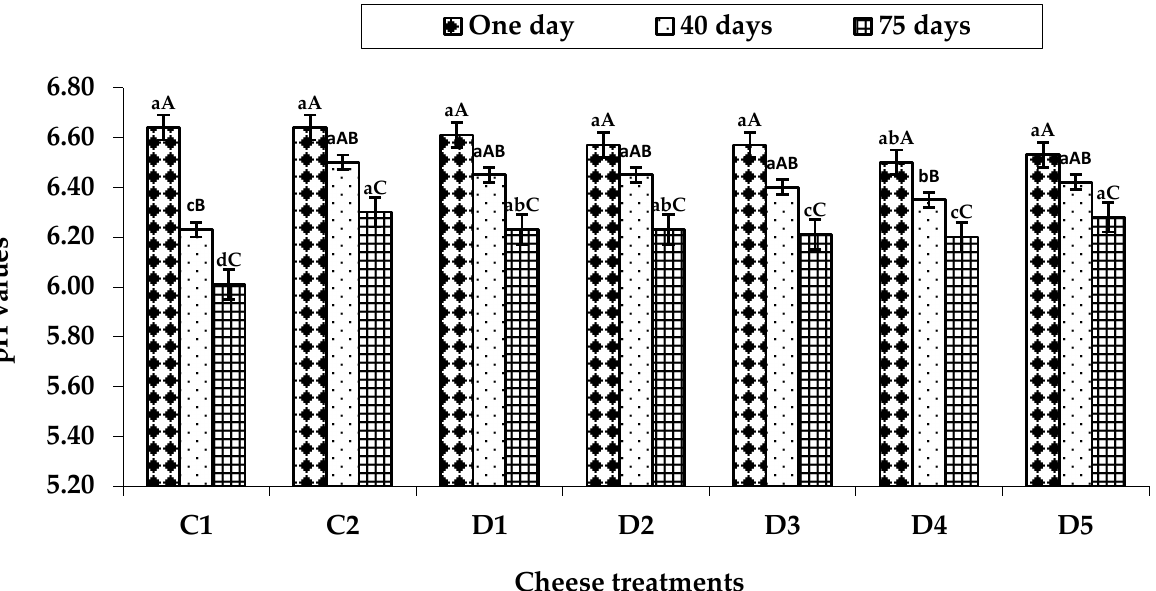
Figure 1. The pH values of the Domiati cheese packaged under different modified atmospheres. C1, control packaged under aerobically atmosphere; C2, control packaged under vacuum; D1, 10% CO 2 /90% N 2 ; D2, 15% CO 2 /85% N 2 ; D3, 25% CO 2 /75% N 2 ; D4, 100% CO 2 ; and D5, 100% N 2 ; a–d bars within the same storage day (treatments) not sharing a common letter are significantly different ( p < 0.05); A–C bars not sharing a common letter during the storage periods are significantly different ( p < 0.05).